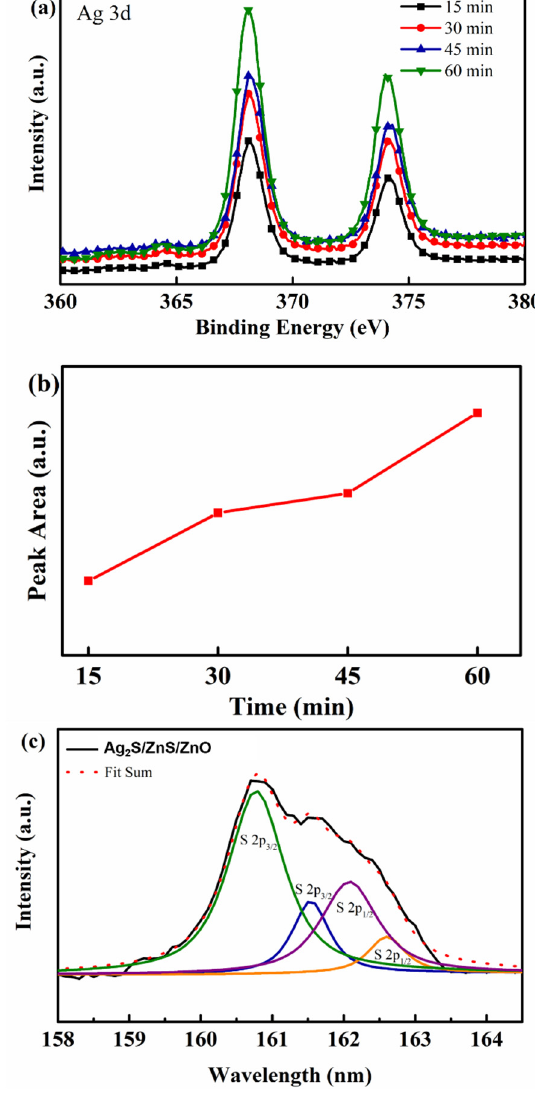
Figure 5. ( a ) XPS spectra of Ag 3d for Ag 2 S/ZnS/ZnO nanocomposites with various immersion time; ( b ) peak area of Ag 3d 5/2 with different immersion time; ( c ) XPS spectra of S 2p for Ag 2 S/ZnS/ZnO nanocomposites with the immersion time of 60 min.